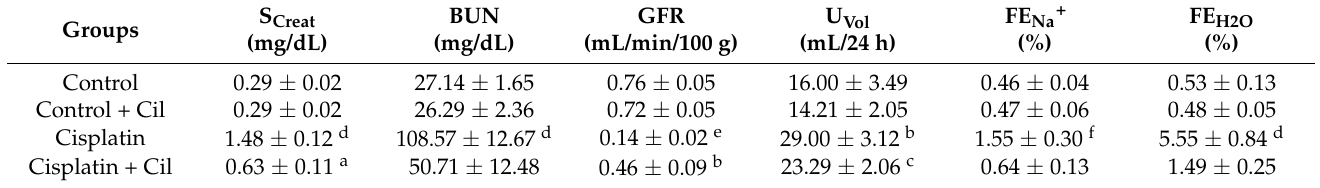
Table 1. Effects of cilastatin treatment on cisplatin-induced renal toxicity in rats. Results are expressed as mean ± SEM. a p < 0.001, b p < 0.005 vs. control and control + cil; c p < 0.05 vs. control + cil; d p < 0.0001, e p < 0.001, f p < 0.0005 vs. all other groups. Cil: cilastatin; S Creat : serum creatinine; BUN: blood urea nitrogen; GFR: glomerular filtration rate; U Vol : urinary volume; FE: fractional